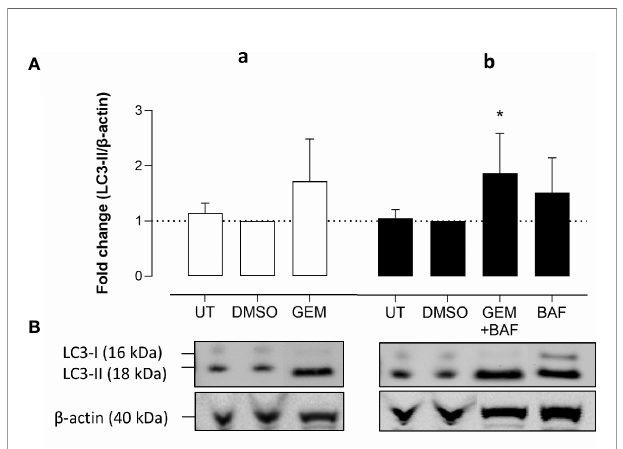
FIGURE 3 | Gemcitabine does not induce autophagy fl ux. (A-a) Panc02 cells were treated in vitro withgemcitabine (GEM, 10 µM) for 32 hours. (A-b) For measuring autophagy fl ux in gemcitabine condition, ba fi lomycin A 1 (BAF, 160 nM) was addedinthe last two hours. Western blots were performed for LC3-II. b -actin servedas a loading control. LC3-II was quanti fi ed relative to b -actin. Data were analyzed using one sample t-test. After normalization, the resulting foldchange was log transformed (log2-base) to obtainanapproximately normaldistribution,*p ≤ 0.05 versus DMSO group. UT, untreated. (B) One representative blot (out of fi ve independent experiments)